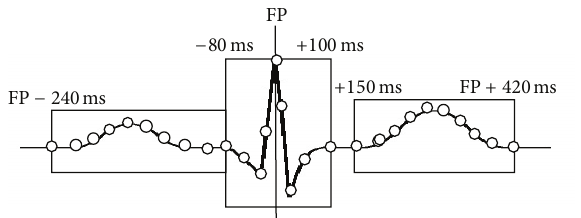
Figure3:ExtractionofECGmorphologicalfeaturesfromthescaled samples of a